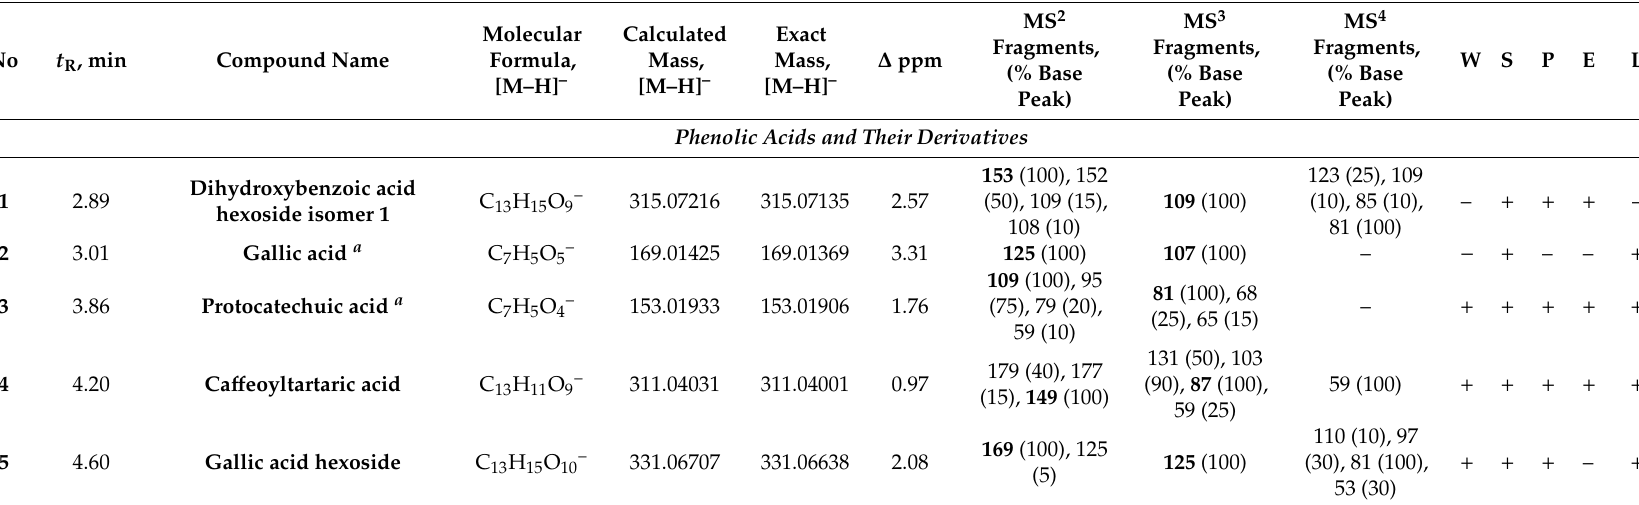
T—table; B—block; Aerodrom, Bunar 12, and Šipˇcanik—vineyards located at the “´Cemovsko” field (Montenegro). Table 2. High resolution MS data and negative ion MS 2 , MS 3 , and MS 4 fragmentation of phenolic compounds identified in Vranac wine (W), grape (seed (S), pulp (P), and skin (E)) and leaf (L)